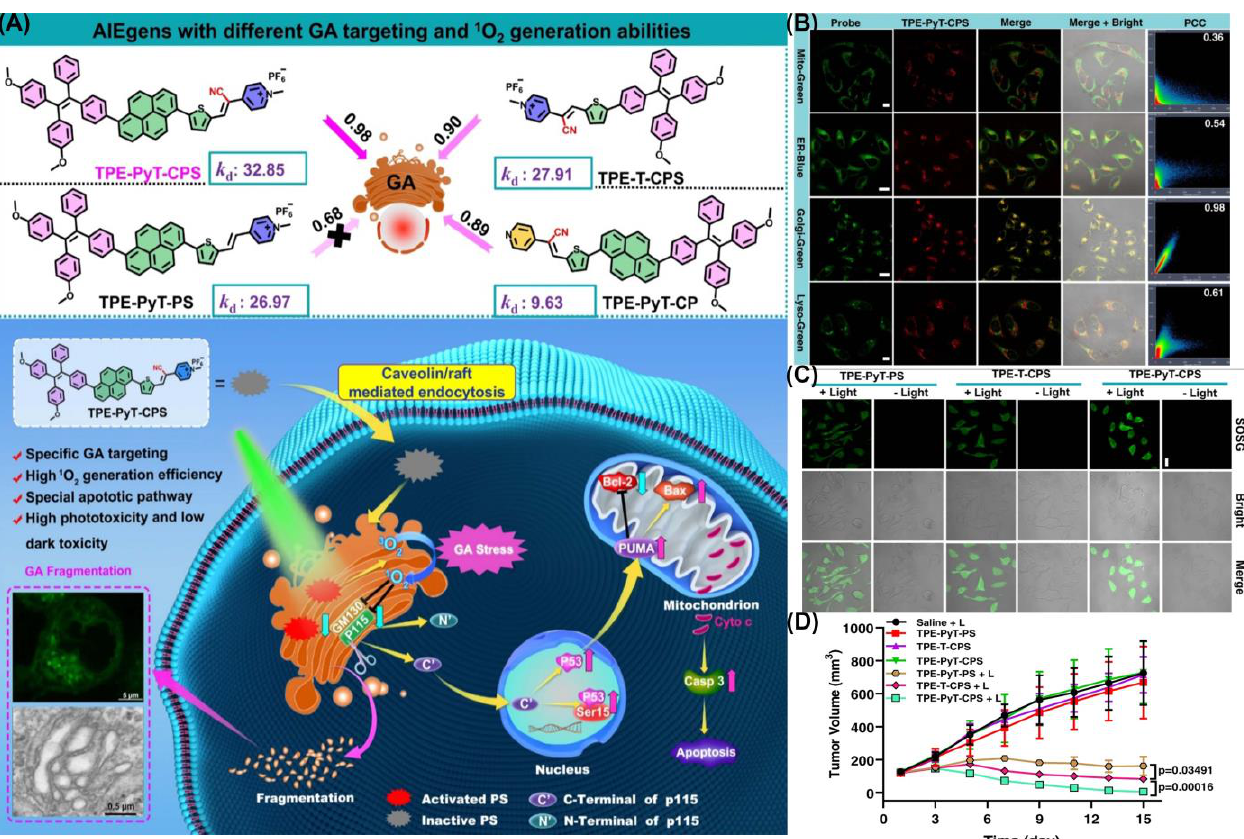
Figure 16. ( A ) Schematic illustration of TPE-PYT-CPS-induced GA stress and induced cell apoptosis upon PDT; ( B ) CLSM of HeLa cells stained with TPE-PYT-CPS and different probes; ( C ) intracellular 1 O 2 detection by CLSM; ( D ) changes of tumor volume treated with different AIEgens. Reprinted with permission from Ref. [129]. Copyright 2022 Nature Communication.